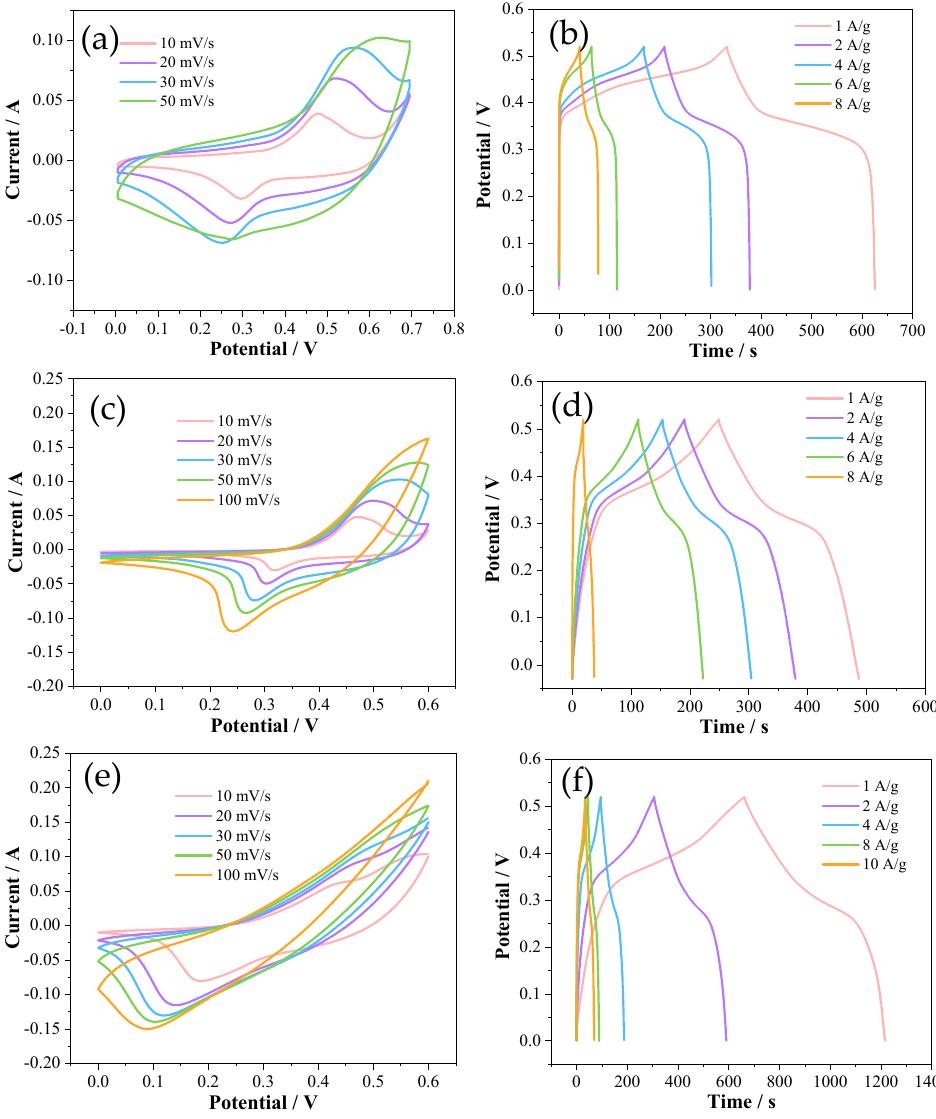
Figure 4. ( a ) CV curves of NiCo 2 S 4 , ( b ) GCD curves of NiCo 2 S 4 , ( c ) CV curves of NiMoO 4 samples, ( d ) GCD curves, ( e ) CV curves of NiCo 2 S 4 @NiMoO 4 samples, ( f ) GCD curves of NiCo 2 S 4 @NiMoO 4 samples.